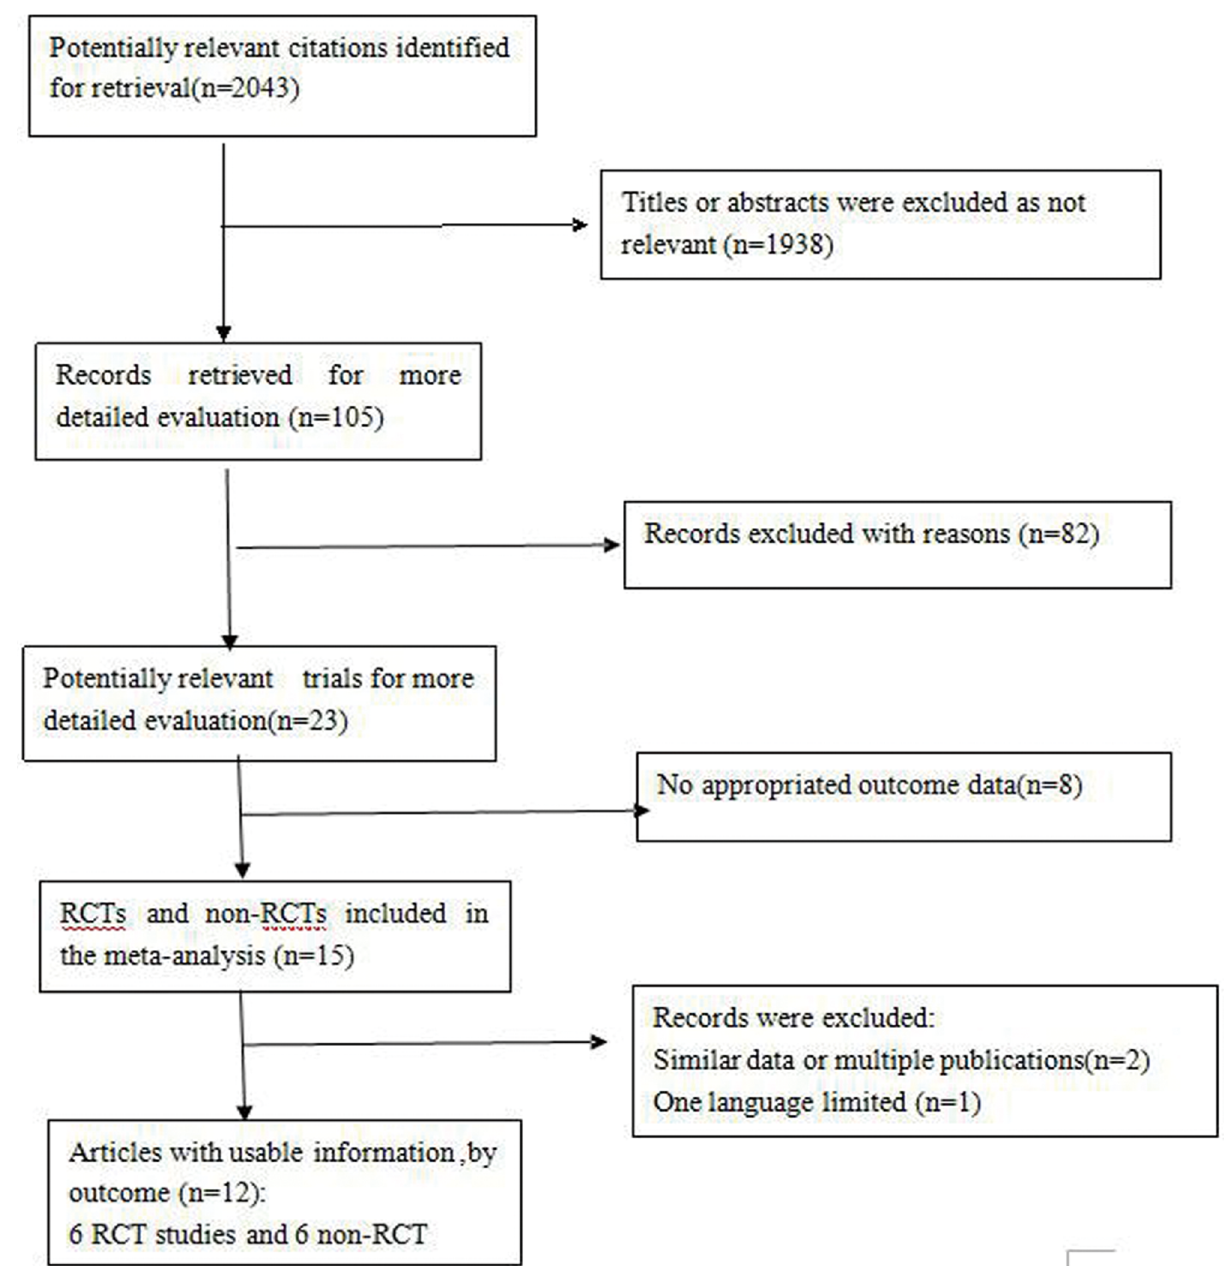
Figure 1. Procedures used for trial selection. Abbreviations: RCT,randomized controlled trial; Non-RCT, non-randomized controlled trial.